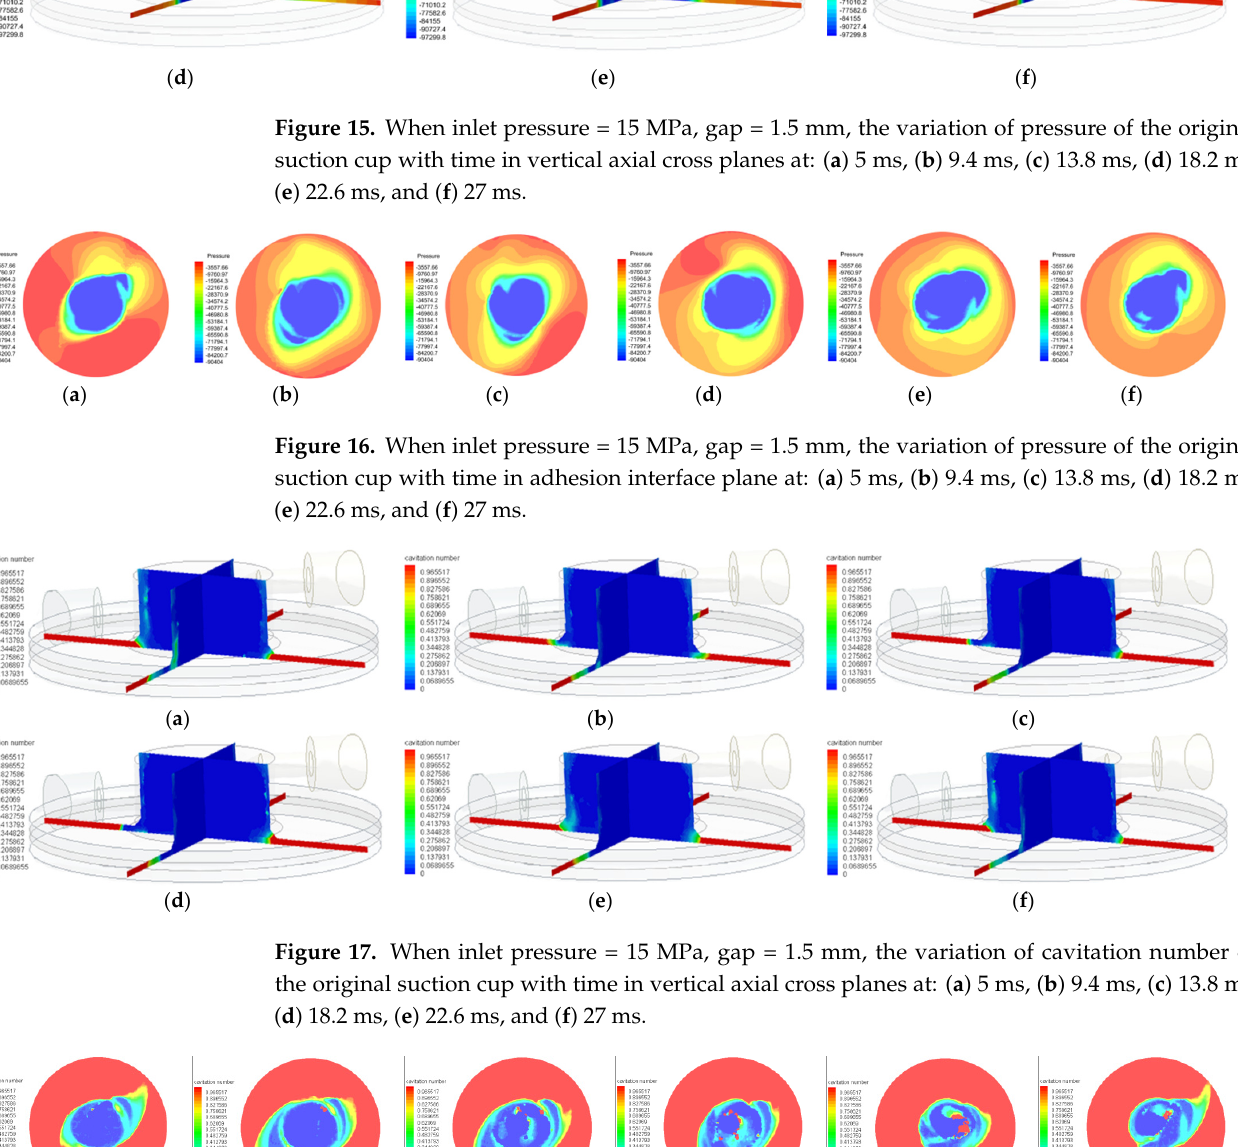
( f ) Figure 13. When inlet pressure = 15 MPa, gap = 1.5 mm, the variation of the velocity vector of the original suction cup with time in vertical axial cross planes at: ( a ) 5 ms, ( b ) 9.4 ms, ( c ) 13.8 ms, ( d ) 18.2 ms, ( e ) 22.6 ms, and ( f ) 27 ms. ( a )